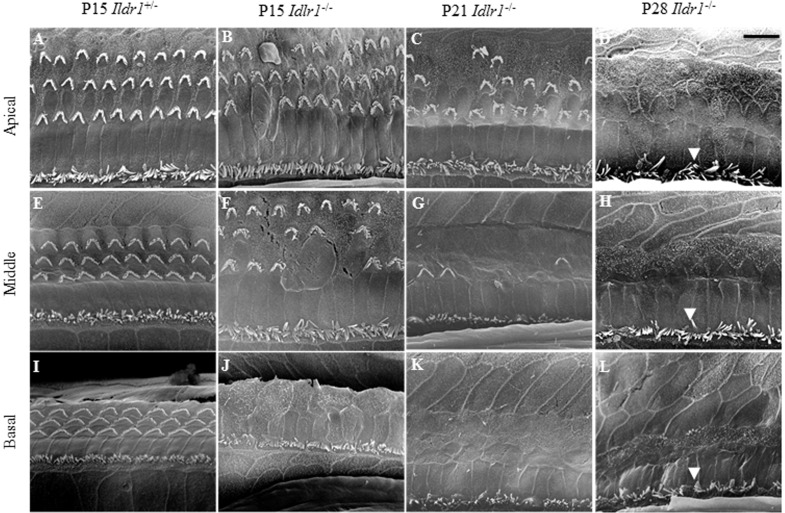
Scanning electron micrographs of cochlear hair cells within the organ of Corti of P15, P21, and P28 mice.Apical (A–D), middle (E–H), and basal turns (I–L) of the cochleae from Ildr1+/− and Ildr1−/− mice were scanned separately. Bold arrowheads in D,H,L point to the stereocilia of the inner hair cells (IHC), which are normal in Ildr1−/− mice. Scale bar: 10 µm.